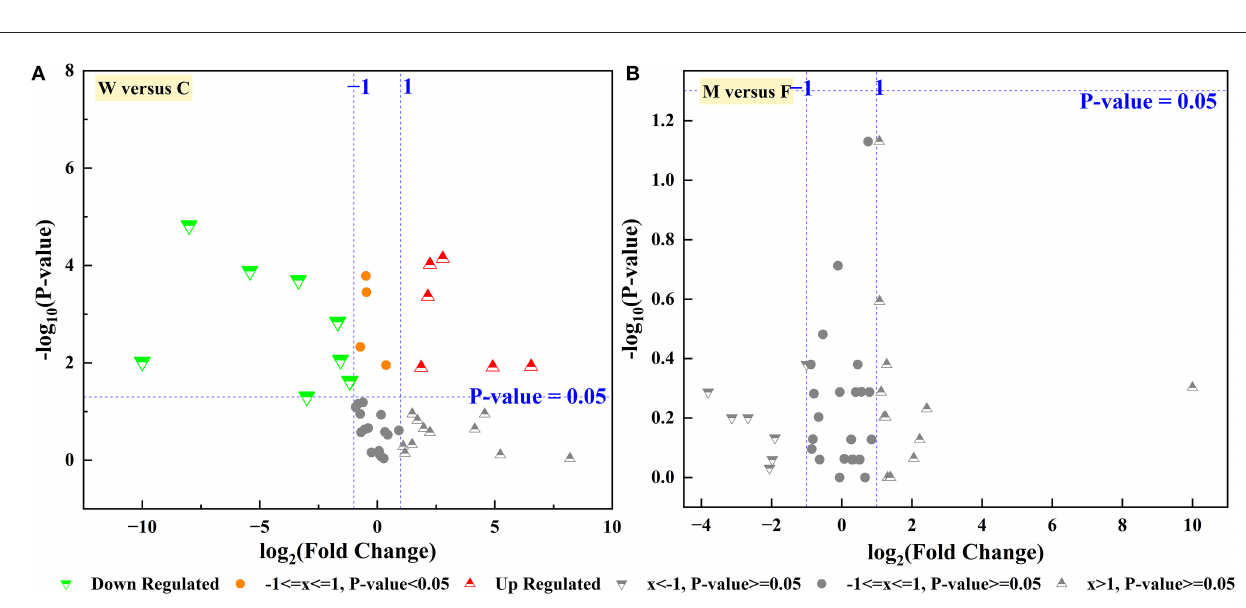
FIGURE7 Volcano plot gut microbiota function of Alpine mush deer. (A) Captive group (C) vs. wild group (W), (B) female group (F) vs. male group (M) in